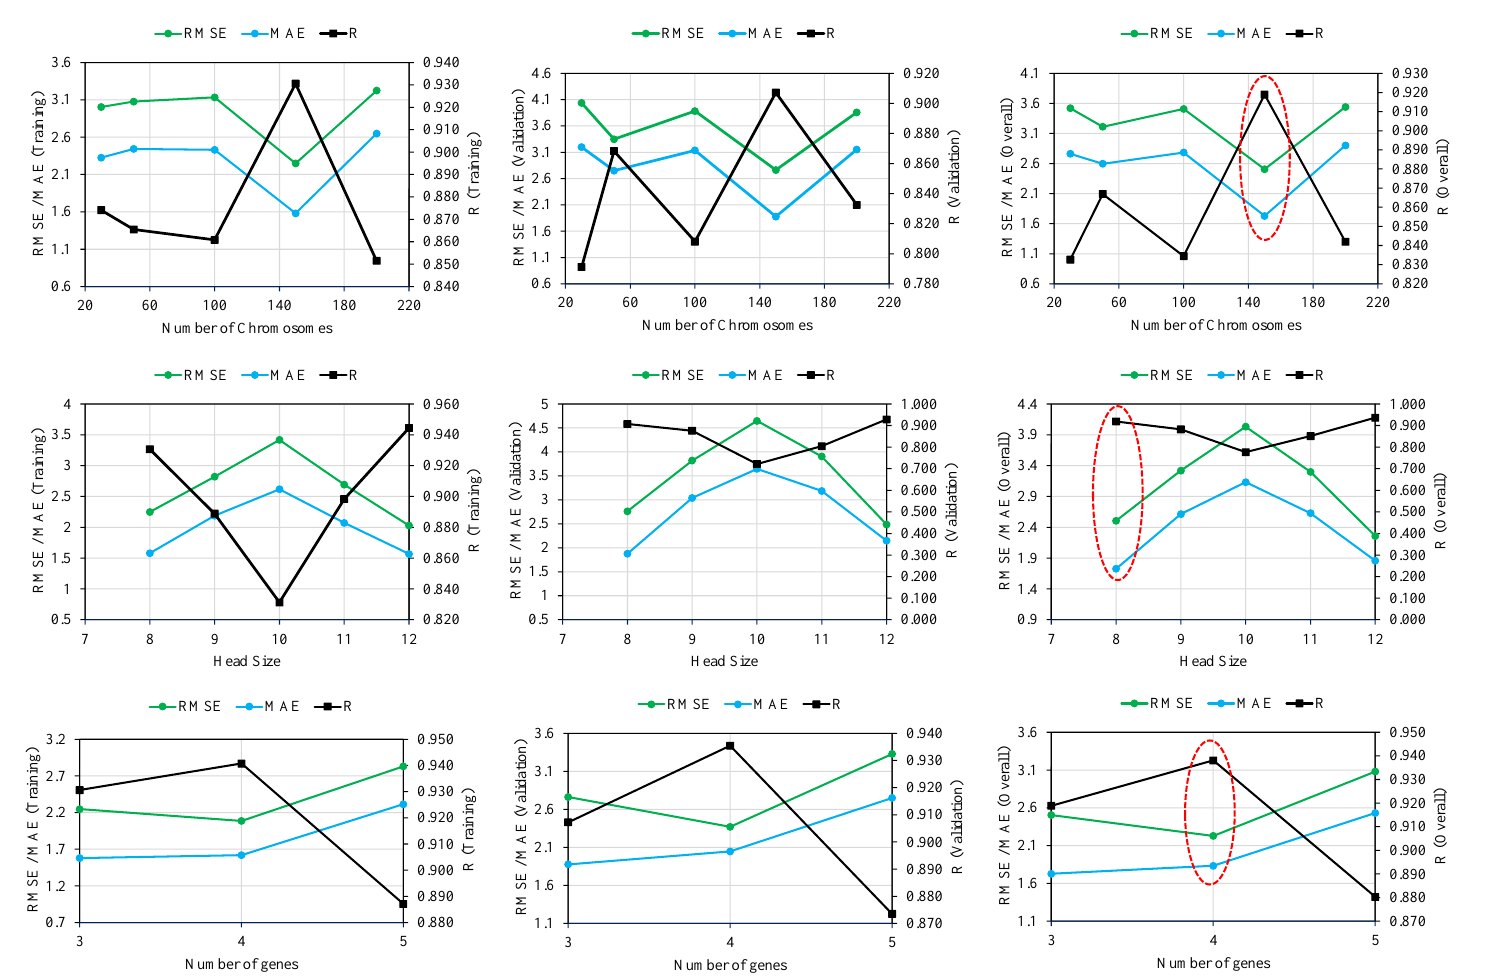
Figure 3. Effect of genetic variables on the performance of the undertaken trials.